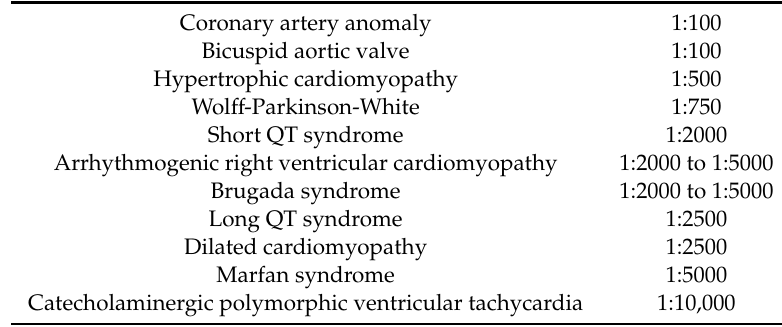
Table 3. Summary of the prevalence of causes of sudden cardiac death in young athletes by